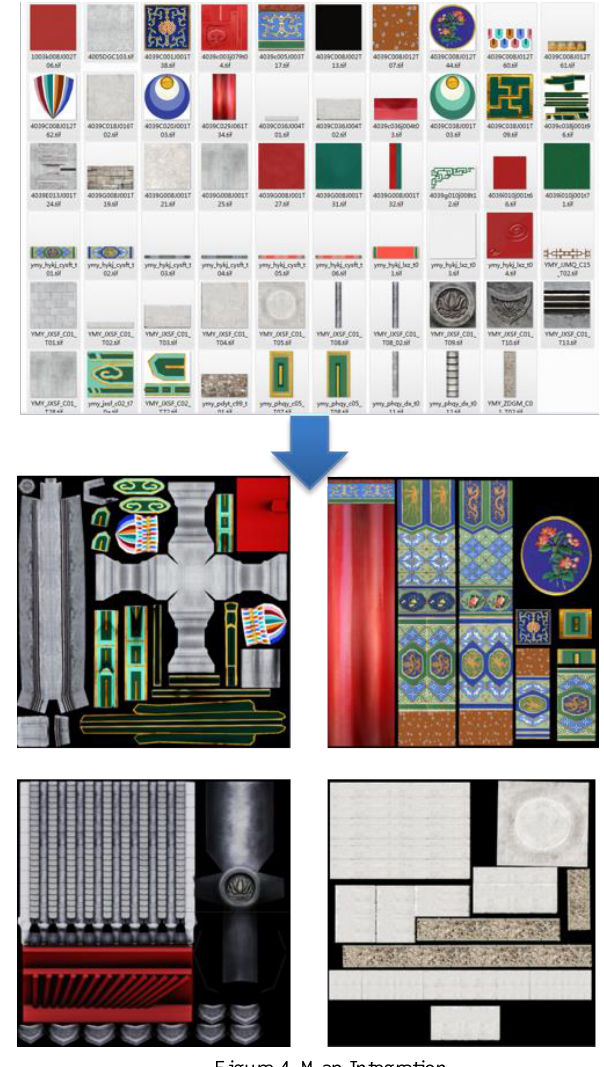
Figure 4. Map Integration